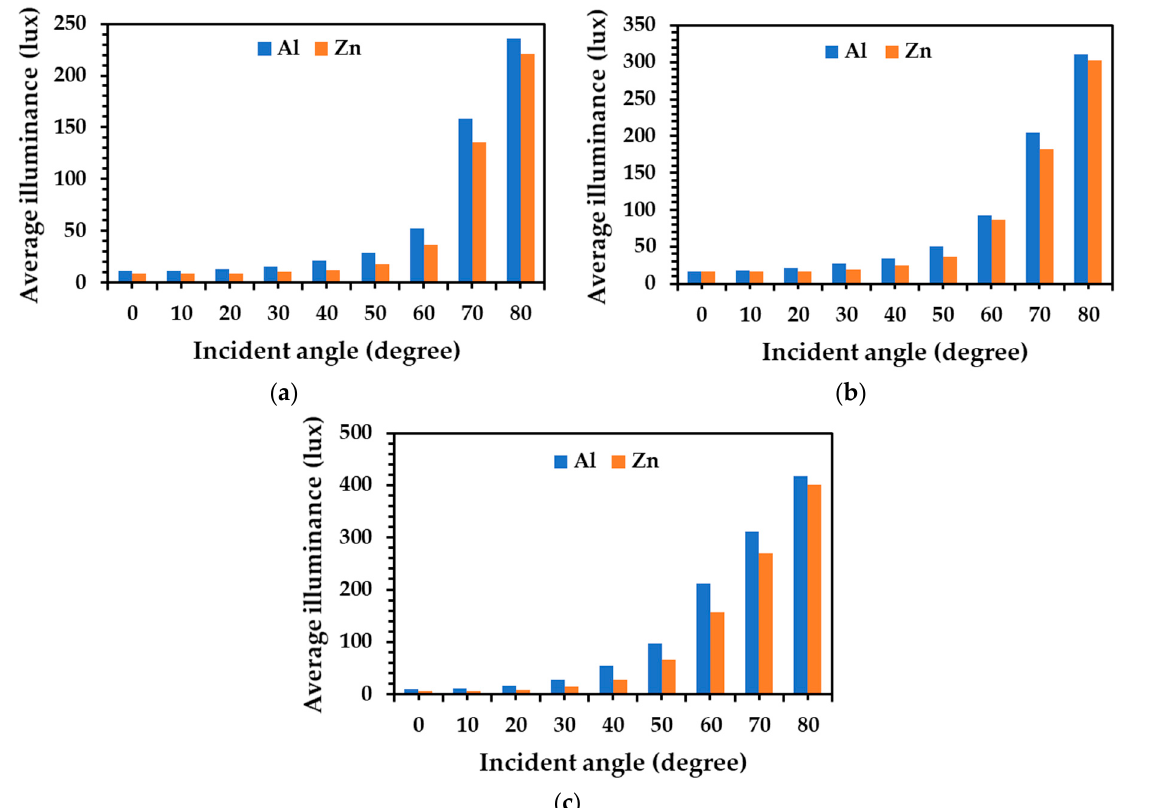
Figure 15. Average internal illuminance of light tube with different materials and diameters ( a ) 0.20 m, ( b ) 0.25 m, and ( c ) 0.30 m.